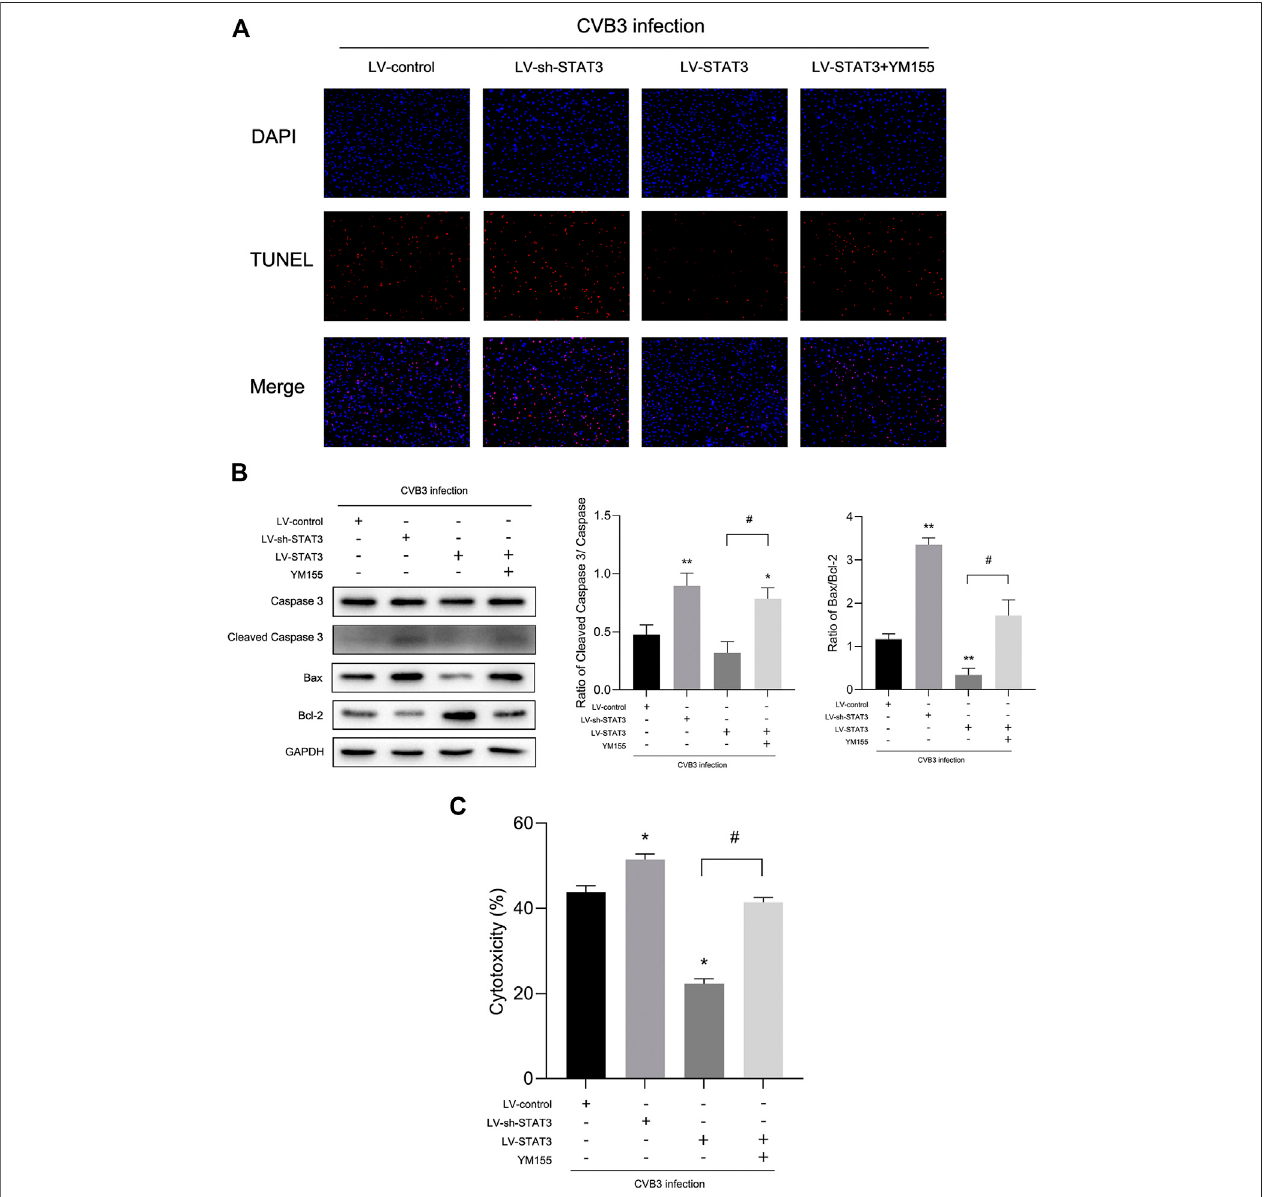
FIGURE 5 | Activated STAT3 inhibited CVB3-induced cardiomyocyte apoptosis via survivin (A) Photomicrographs (100 × ) of apoptotic cells. (B) The expression of Bax and Cleaved Caspase-3 was measured by western blot ( n (cid:2) 4). (C) The cytotoxicity tested by LDH assay kit in different groups ( n (cid:2) 4). * p < 0.05, ** p < 0.01 vs Lv-control group, # p < 0.05 vs Lv-STAT3